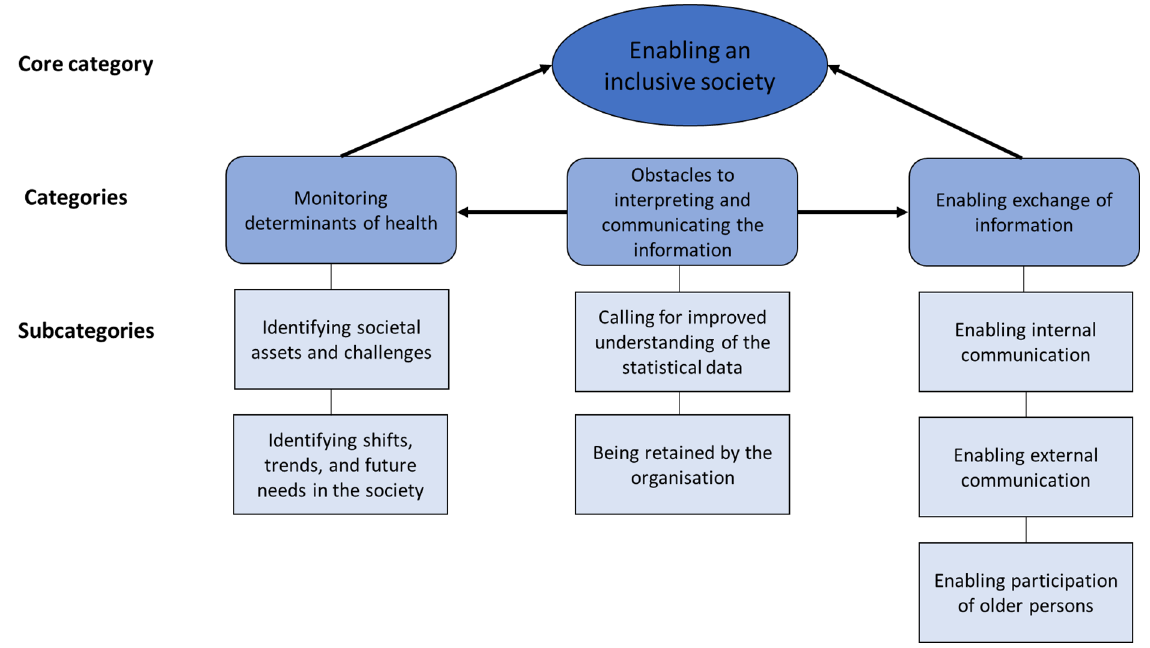
Figure 2. The core category Enabling an inclusive society , with its categories, and the category Obstacles to interpreting and communicating the information , which influences the other categories.